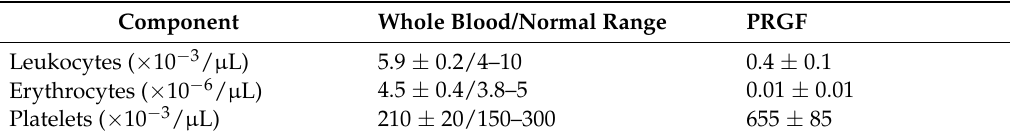
Table 2. Quantitative assessment of the main growth factors, cytokines, and chemokines in PRGF fraction.